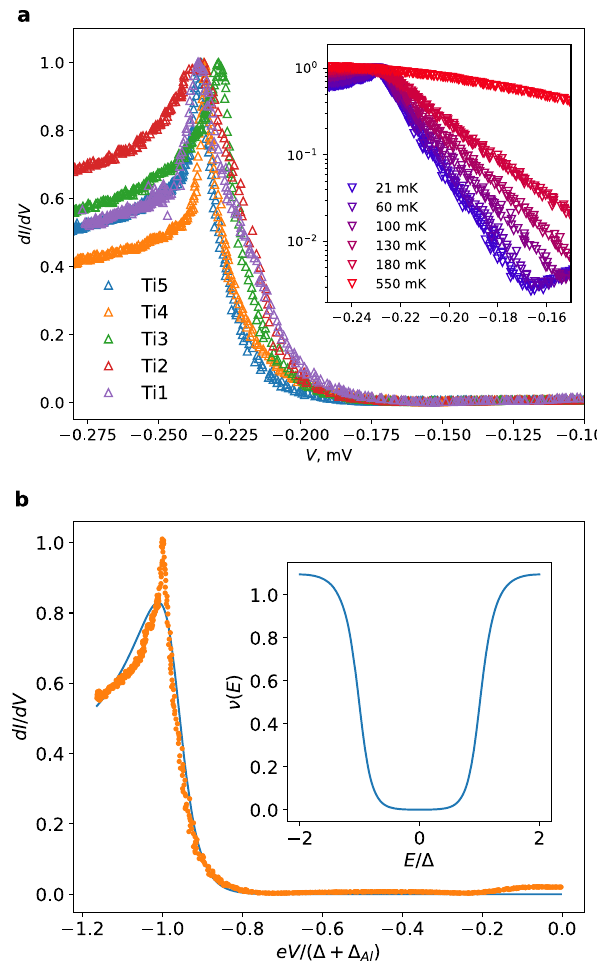
Fig. 4 Local differential conductance and electron density of states. a Differential conductance d I /d V as a function of voltage V measured in Ti − Al tunnel junctions at T ≃ 21 mK for fi ve samples Ti1 to Ti5. A sharp peak is observed at e ∣ V ∣ = Δ + Δ Al . Inset: The same data for sample Ti3 at different temperatures. b Fit of the data for sample Ti3 at T ≃ 21 mK to the theory 40 . Inset: The density of states ν (in units of the normal density of states at the Fermi energy) as a function of energy E reconstructed for the same sample at the same T . Error bars are smaller than data